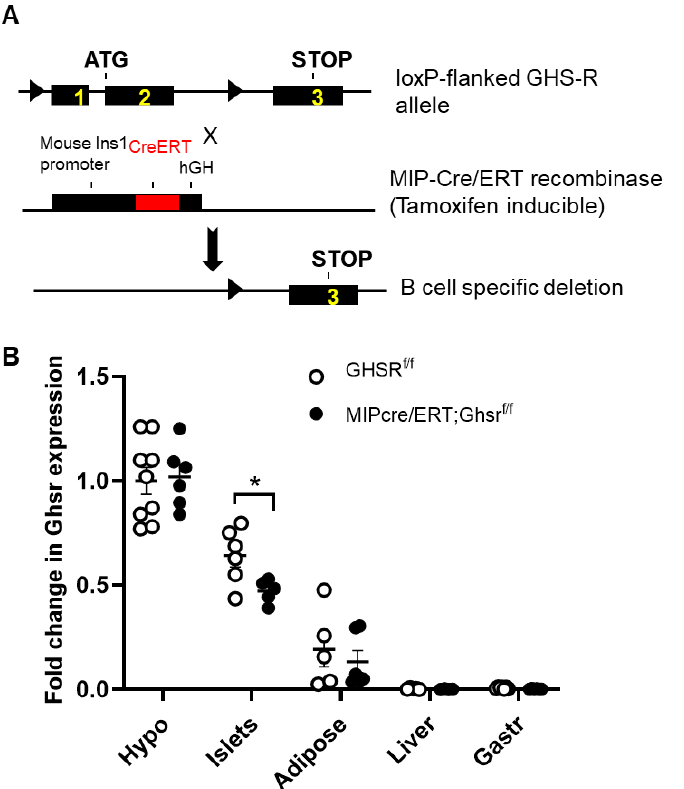
Figure 2. Validation of β -cell-specific GHS-R deletion in MIP-CreERT;Ghsr f/f mice. ( A ) Schematic diagram of the recombination between the loxP-flanked GHS-R allele and MIP-CreERT. Tamoxifen induction of Cre ledsto recombination and excision of exons 1 and 2. The triangle represents the loxP sites. ( B ) Expression of GHS-R in various tissues of Ghsr f/f and MIP-CreERT;Ghsr f/f mice. * p < 0.05 Ghsr f/f vs. MIP-Cre/ERT;Ghsr f/f . n = 3–9. Hypo: hypothalamus, Gas: gastrocnemius muscle, Fat—inguinal fat.